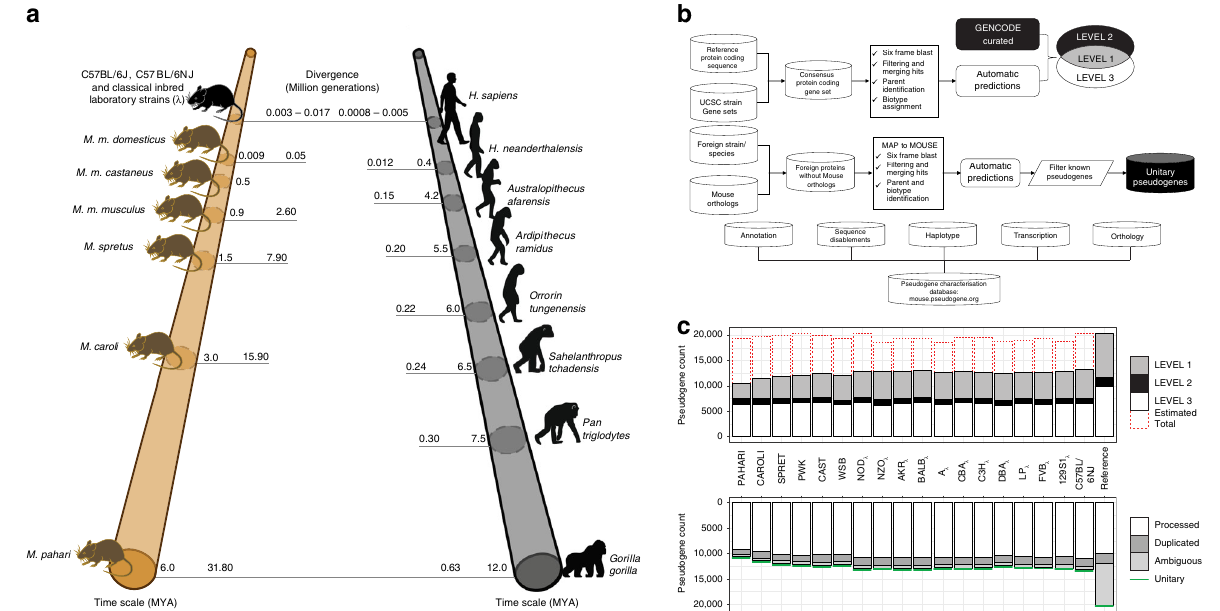
Fig. 1 Pseudogene annotation. a Comparison on the evolutionary time scale of the divergence in selected primates and murine taxa. Each point on the primate time scale indicates the split from the human in million years (MYA). Each point on the murine time scale indicates the divergence time for splits among the wild-derived species and strains, and between M. m. domesticus and the classical laboratory inbred strains (denoted by λ ). b (top) Pseudogene annotation work fl ow for mouse strains. b (middle) Unitary pseudogene annotation pipeline. b (bottom) Mouse pseudogene characterisation resource work fl ow. c Summary of mouse strains ’ pseudogene annotation. Level 1 are pseudogenes identi fi ed by automatic pipelines and liftover of manual annotation from the reference genome; Level 2 are pseudogenes identi fi ed only through the liftover of manually annotated cases from the reference genome; Level 3 are pseudogenes identi fi ed only by the automatic annotation pipeline. The total number of pseudogenes in each biotype class and for each con fi dence level in each strain is available in Supplementary Table